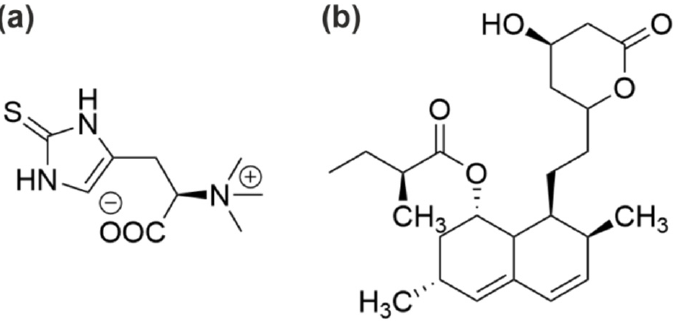
Figure 2. ( a ) Ergothioneine is a rare thiourea derivative of histidine, named after the ergot fungus Claviceps and sold as dietary supplement, although its benefit to human metabolism is uncertain [43]. ( b ) Lovastatin is a cholesterol lowering polyketide and a genuine constituent of edible mushrooms. It inhibits 3-Hydroxy-3-methylglutaryl-CoA reductase [44].